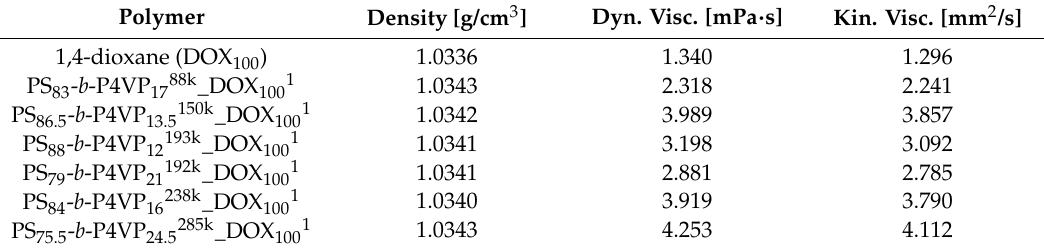
Table 1. List of the used BCP solutions, their density, dynamic and kinematic viscosity.